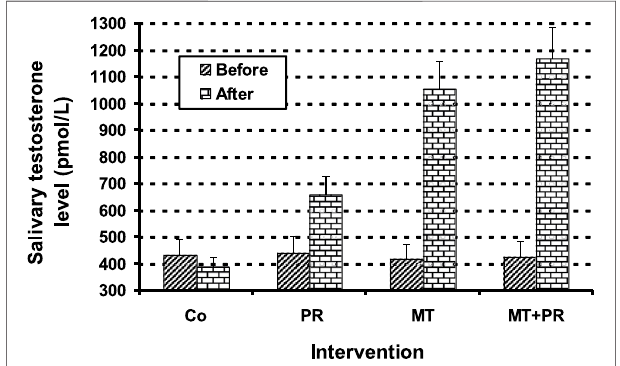
FIGURE1| Evolution ofsalivary Tlevels ofTunisian elderly male patients withmildADinCo,PR,MTandMT+PRgroupsafter4monthsofintervention at the rate of three sessions of 60-min per week. The results correspond to mean±standarddeviationfor6-7patients.Intervention:Co(control),PR (physic rehabilitation), MT (music therapy) and MT + PR (music therapy + physic rehabilitation).